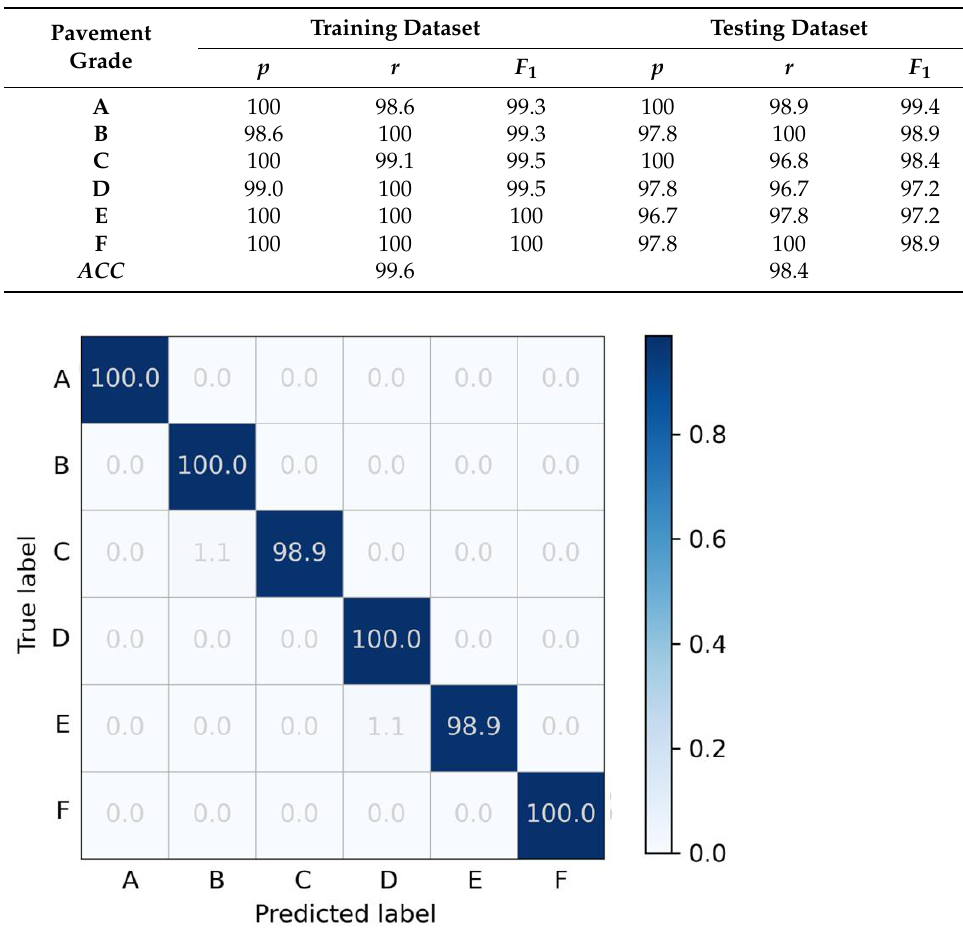
To exhibit the feature extraction effect of 1D-RCNN, uniform manifold approxima- tion and projection (UMAP) is used to downscale and visualize the extracted features. Figure 9a–d represent the output after the first convolutional pooling, the output after the second convolutional pooling, the output after the third convolutional pooling, and the fully connected layer output, respectively. It can be seen that, after three layers of convolutional pooling of the output features, feature data with the same labels gradually increase the similarity of the output features in two dimensions with the convolutional layer progression. Moreover, after the convolutional pooling feature selection stage, the data with different labels achieve significant classification results in the fully connected